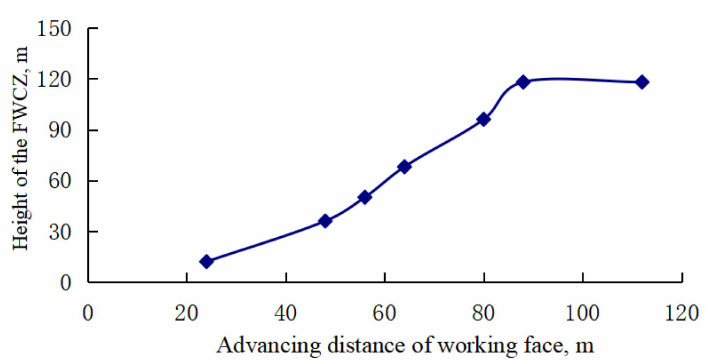
Figure 7. Relationship between height of the FWCZ and advancing distance of working face under fully mechanized mining conditions.